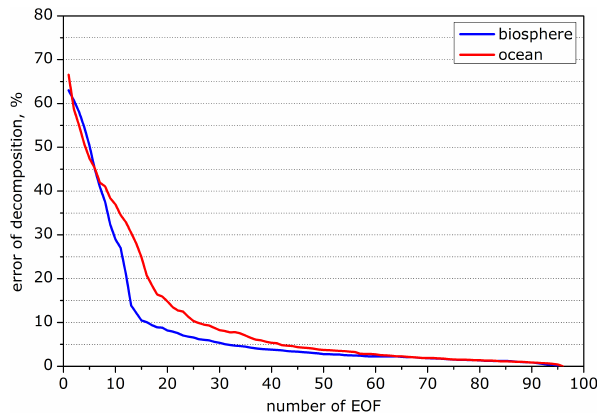
Fig. 2. Error of decomposition (y-axis) between original emission fields and those restored depends on number of most significant EOFs